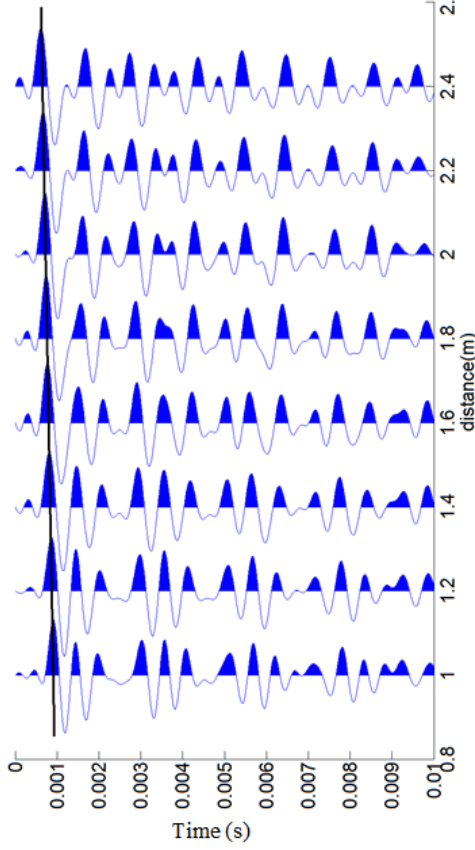
Figure 11. Diagram of point vs time.